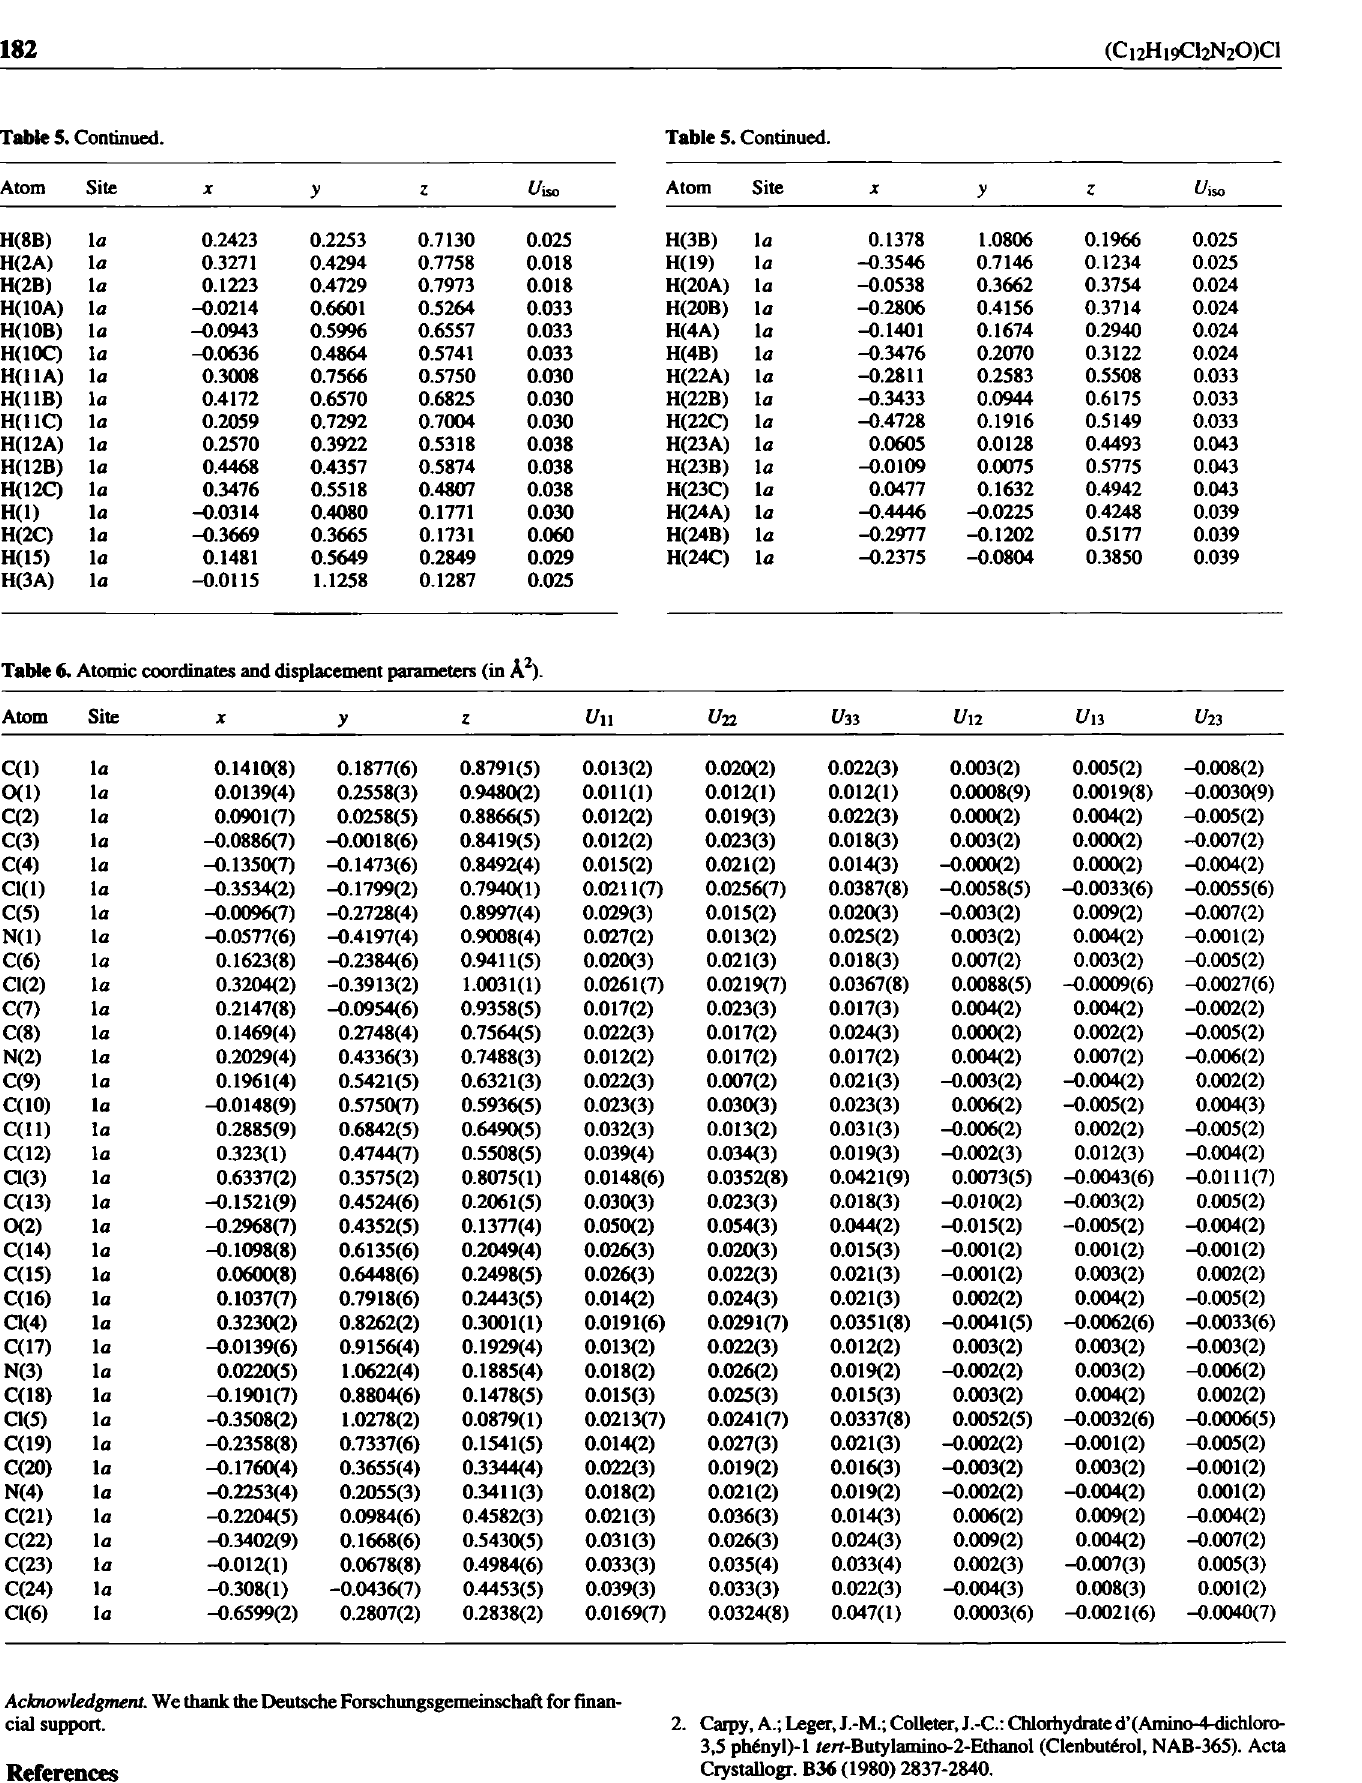
Table 6. Atomic coordinates and displacement parameters (in A 2